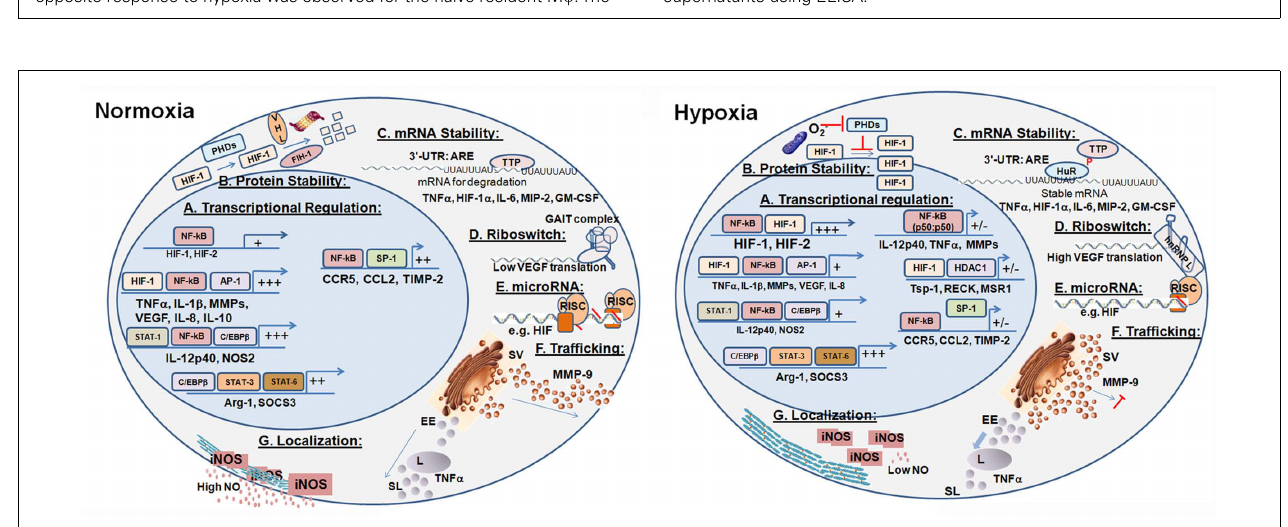
human monocytic cell lines (C) U937 ( n = 12) and (D) THP-1 ( n = 18) were primed with either LPS (100ng/ml) or IFN β (10U/ml) for 48h in normoxia, before LPS (1 μ g/ml) was added and cells were incubated for additional 24h in normoxia or hypoxia. Hypoxia increasedTNF α secretion in naïve Mo, but inhibited it in IFN β -primed cells.TNF α was determined in the supernatants using ELISA.